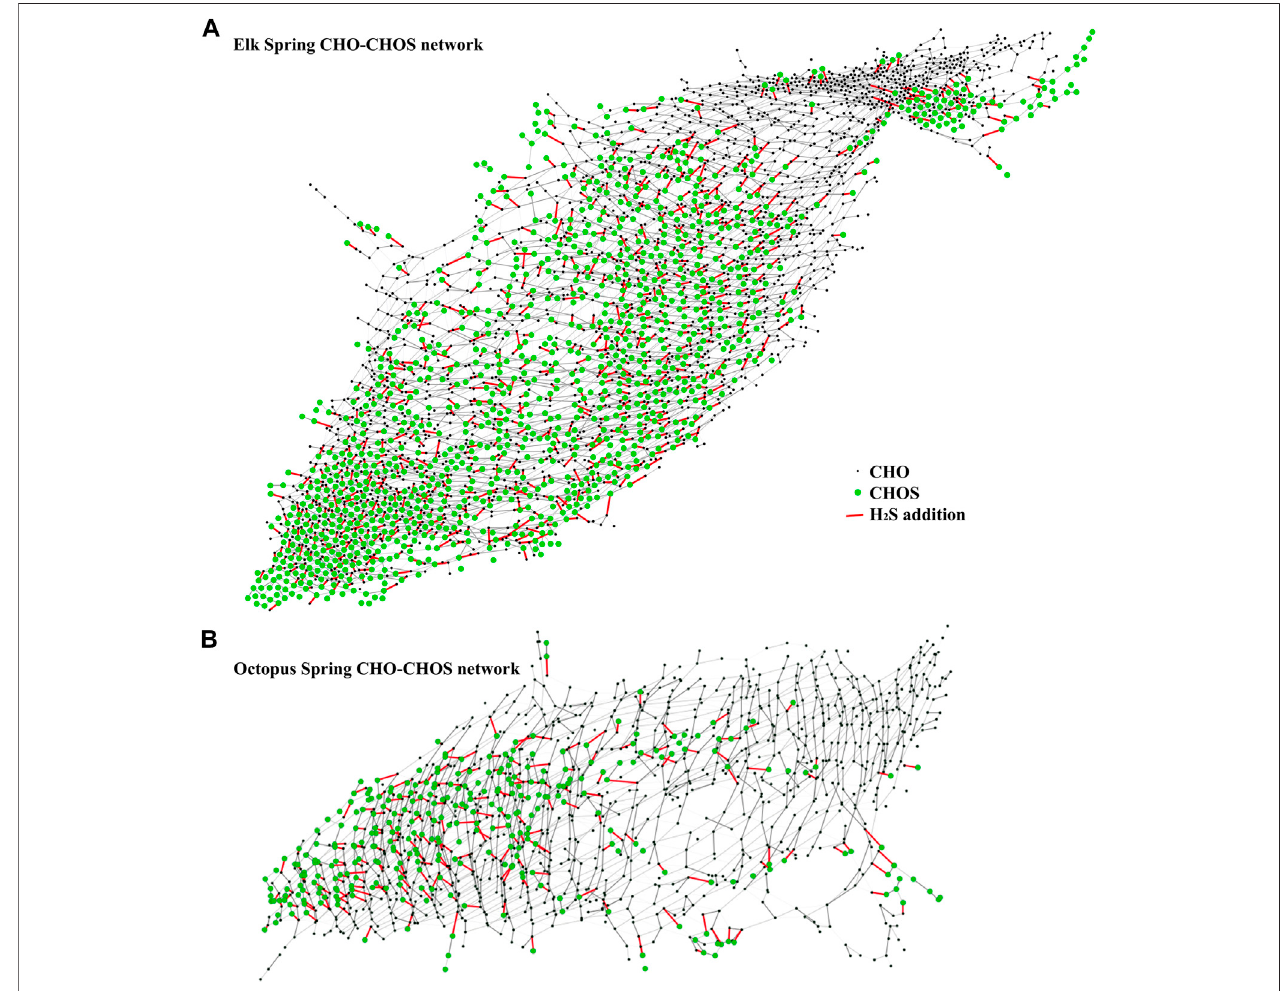
FIGURE9| MassdifferencenetworkanalysisbetweenCHOions(blacknodes)andCHOSions(greennodes)connectedbyamassofH 2 S=33.987,721amu(red edges) for Elk Spring SPE-YDOM (A) and Octopus Spring SPE-YDOM (B) .